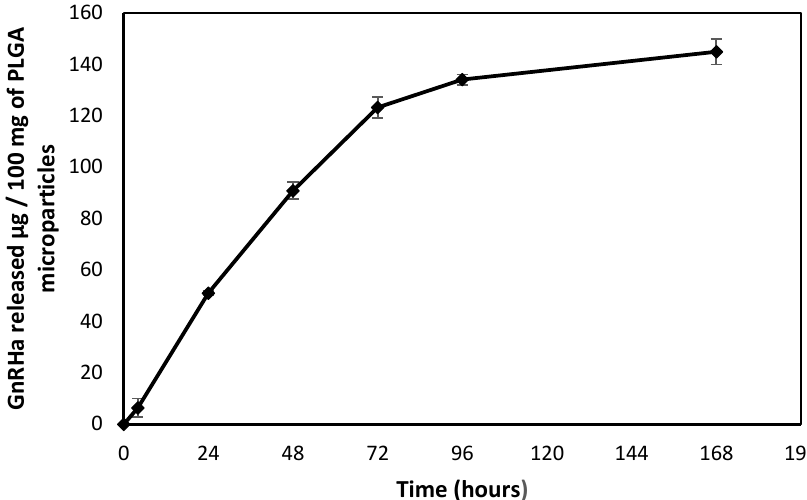
Figure 1. Kinetics of release of GnRHa from PLGA microparticles.